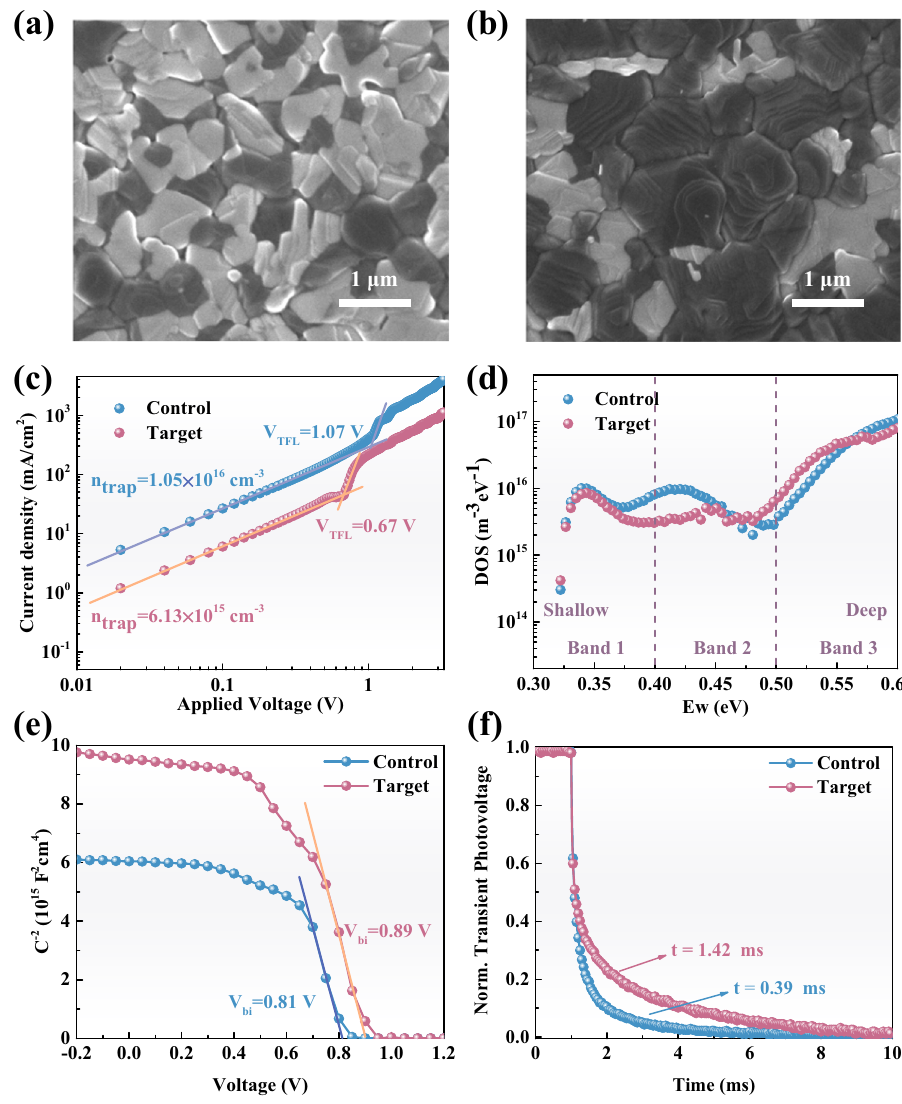
Fig. 4 | The effect of moisture treatment on the properties of the fi nal per- ovskite fi lmand the carrier transport ofthe complete solar cells. a , b Top-view SEM images of the annealed control and target perovskite fi lms. c SCLC measured from the electron-only device with the structure of Glass/ITO/SnO 2 /perovskite/